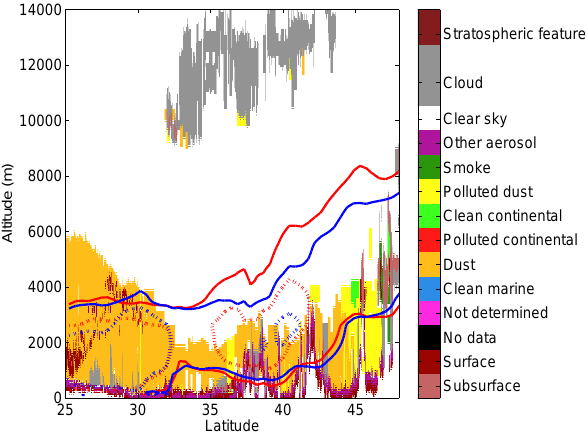
Fig. 6. Vertical profile of aerosols measured by CALIOP on 24 March 2008. The corresponding trace is plotted in Fig. 4a. The AOD of dust aerosols simulated by REF is indicated with the red line, by NEW with the blue line (solid line: dust AOD=0.01, dashed line: dust AOD=0.03).